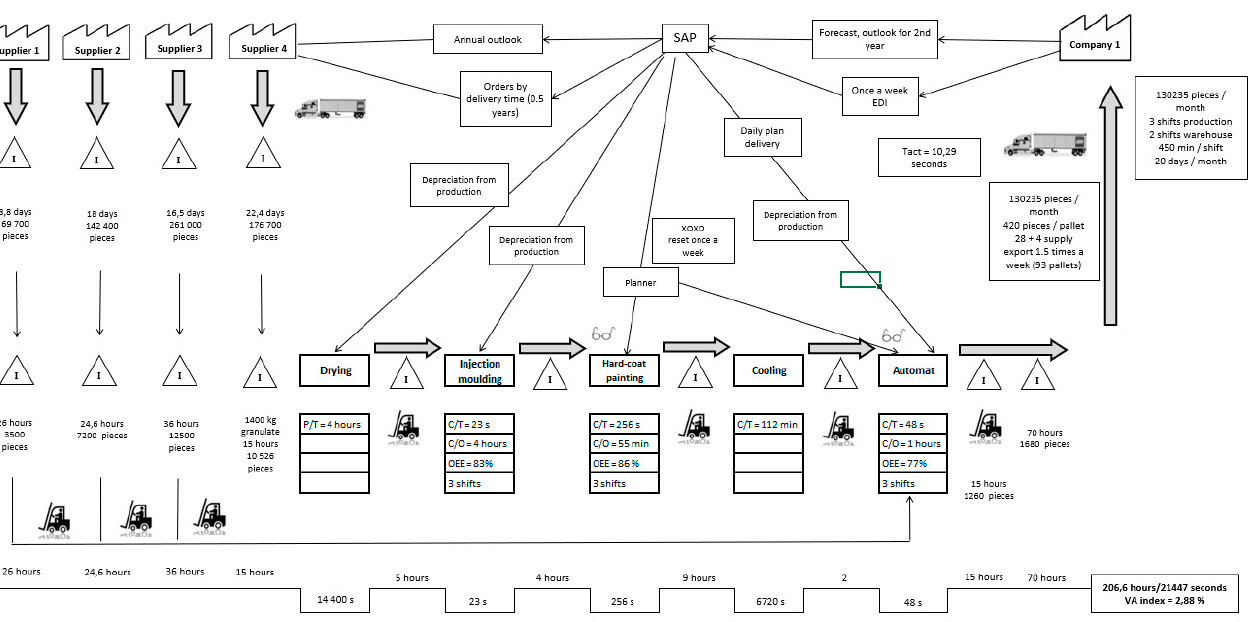
Table 3. Maturity model–environmental aspect indicators .